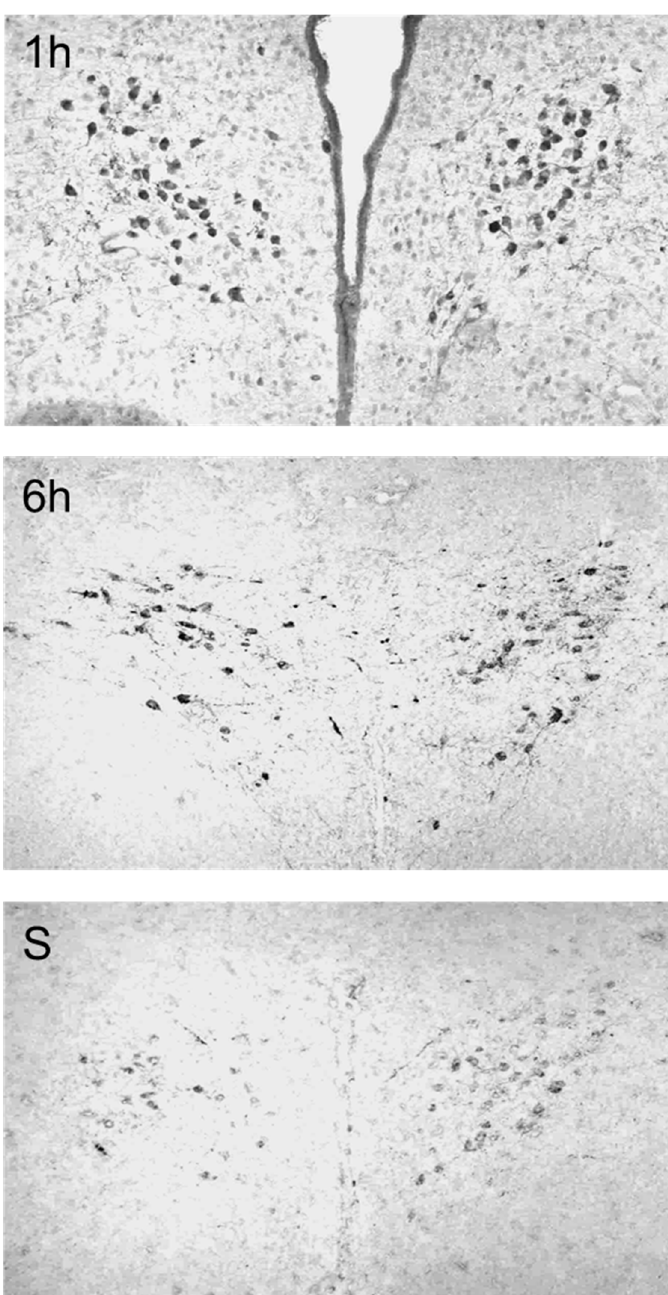
Figure A9. Oxytocin immunoreactivity in the paraventricular nuclei of Syrian hamsters. Comparison among 1 h manual sleep deprivation (1 h, group 3a), 6 h manual sleep deprivation (6 h, group 3b) and sleep (S, group 5). Magnification: 80×.